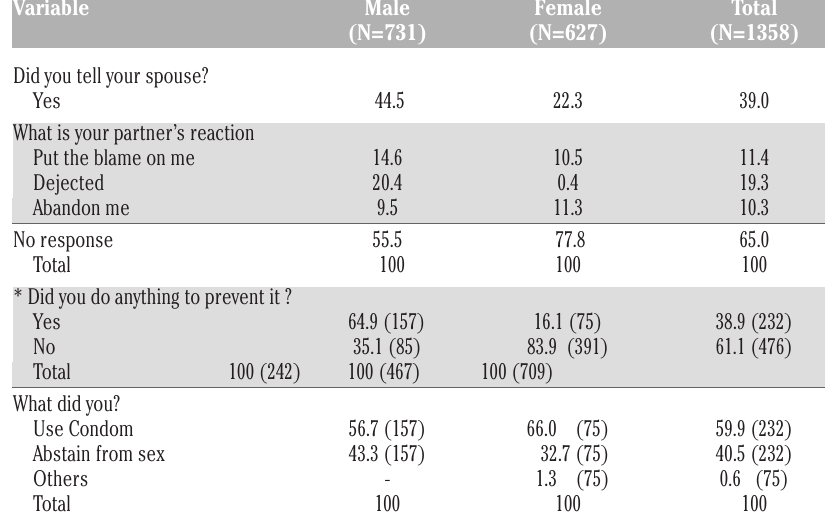
Table 4. Percentage distribution of gender-related potential risk of HIV heterosexual